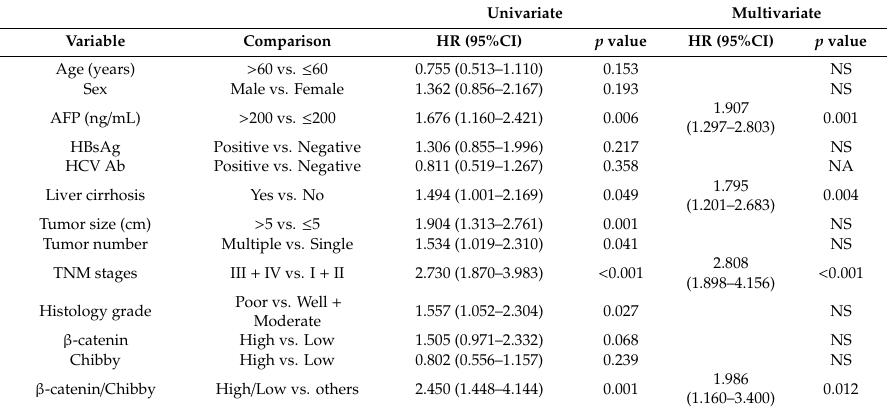
Table 2. Univariate and multivariate analysis of factors associated with HCC